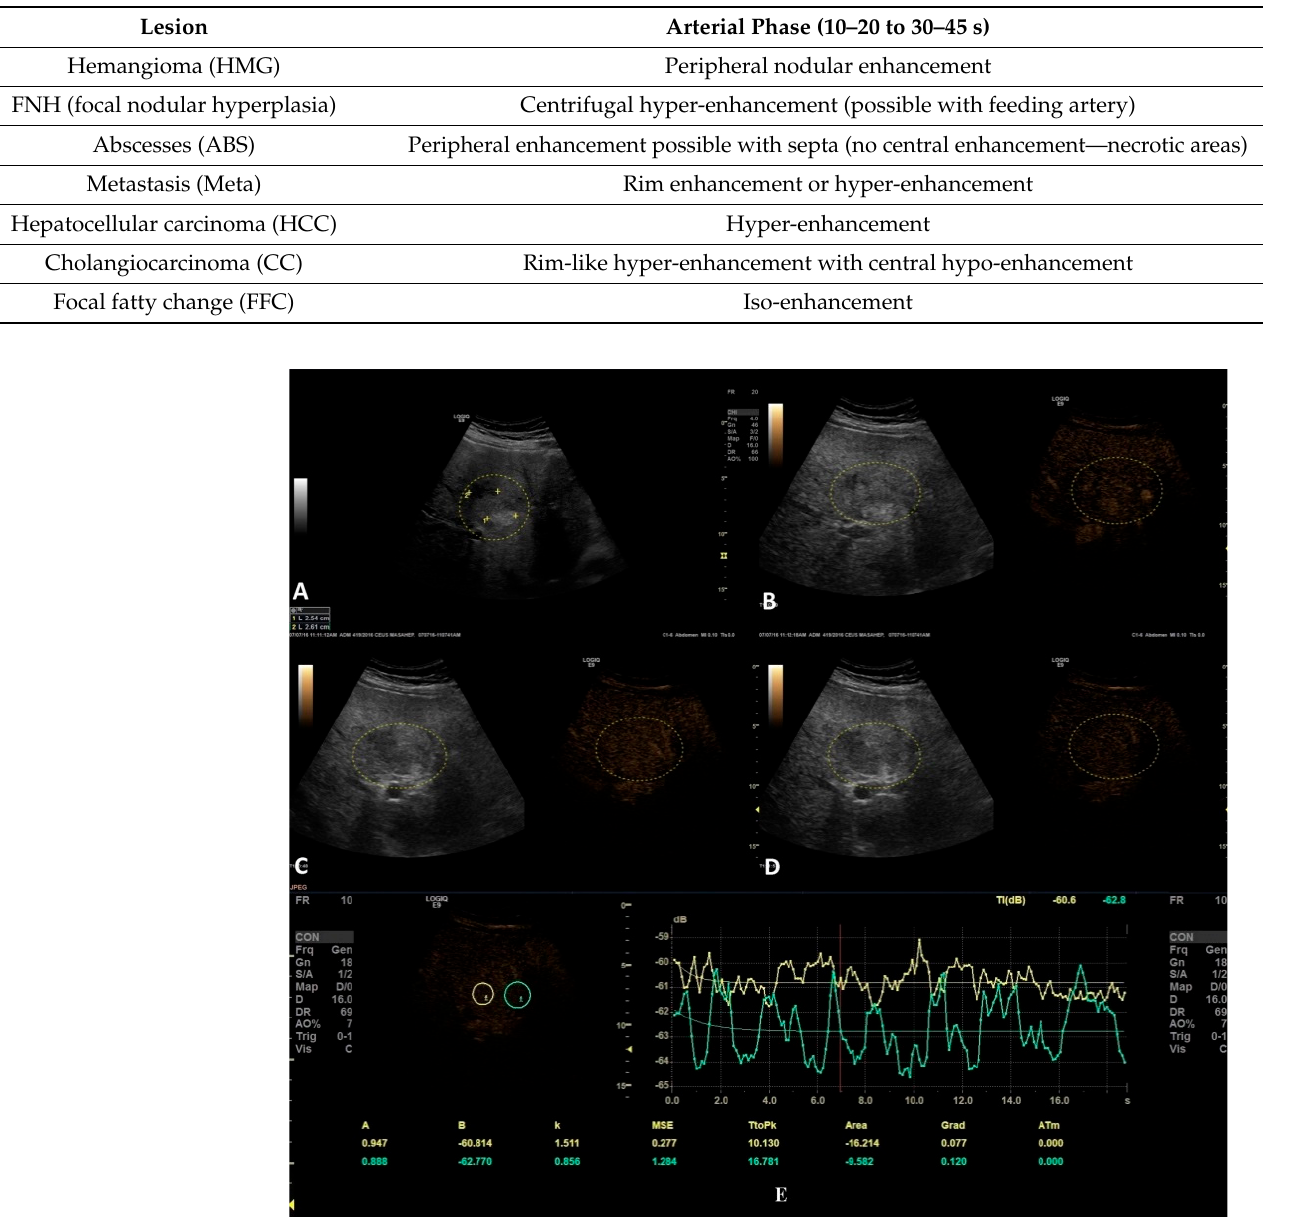
Table 1. Typical features of the enhancement patterns in CEUS—the arterial phase of the most frequent lesions encountered in daily practice that require CEUS evaluation.